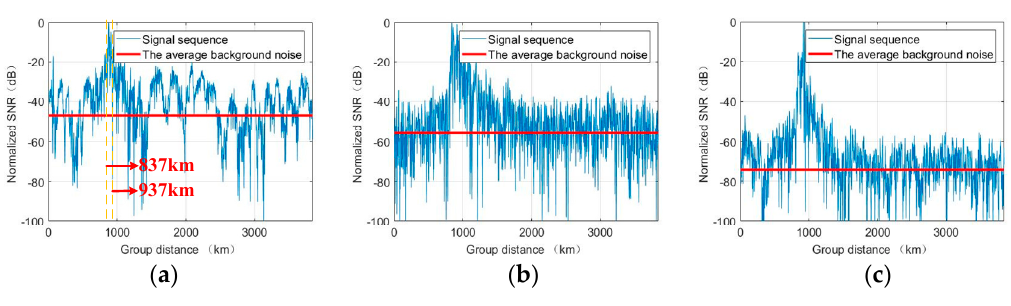
Figure 18. Normalized SNR of 7.8 MHz; ( a ) Channel 1; ( b ) SMI; ( c ) ESB.